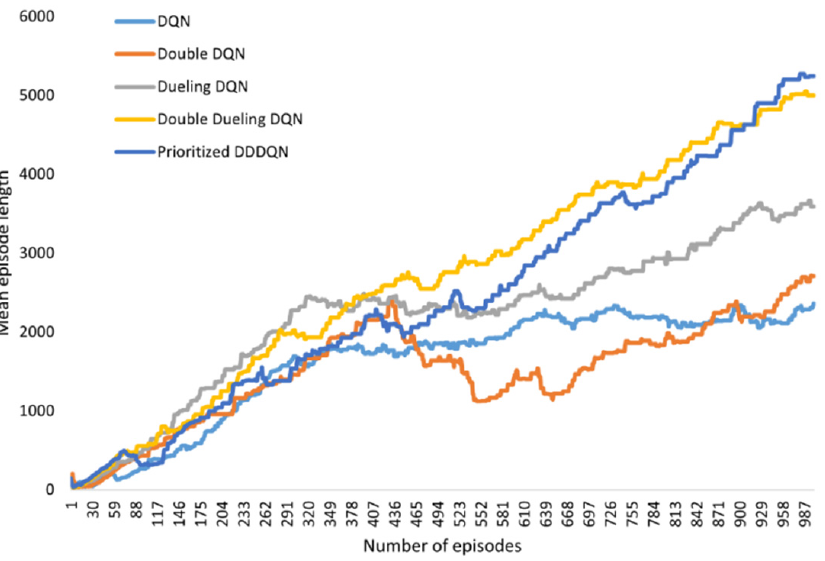
Figure 6. Comparison of the convergence speed between the proposed algorithm and other DQN derivative algorithms.